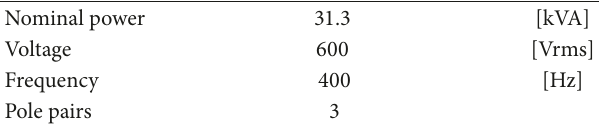
Table 3: Generator